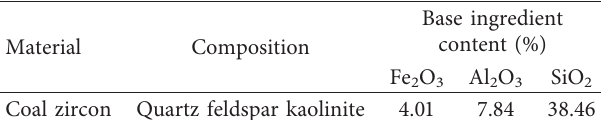
Table 4: Test results of the composition of the red soil particle